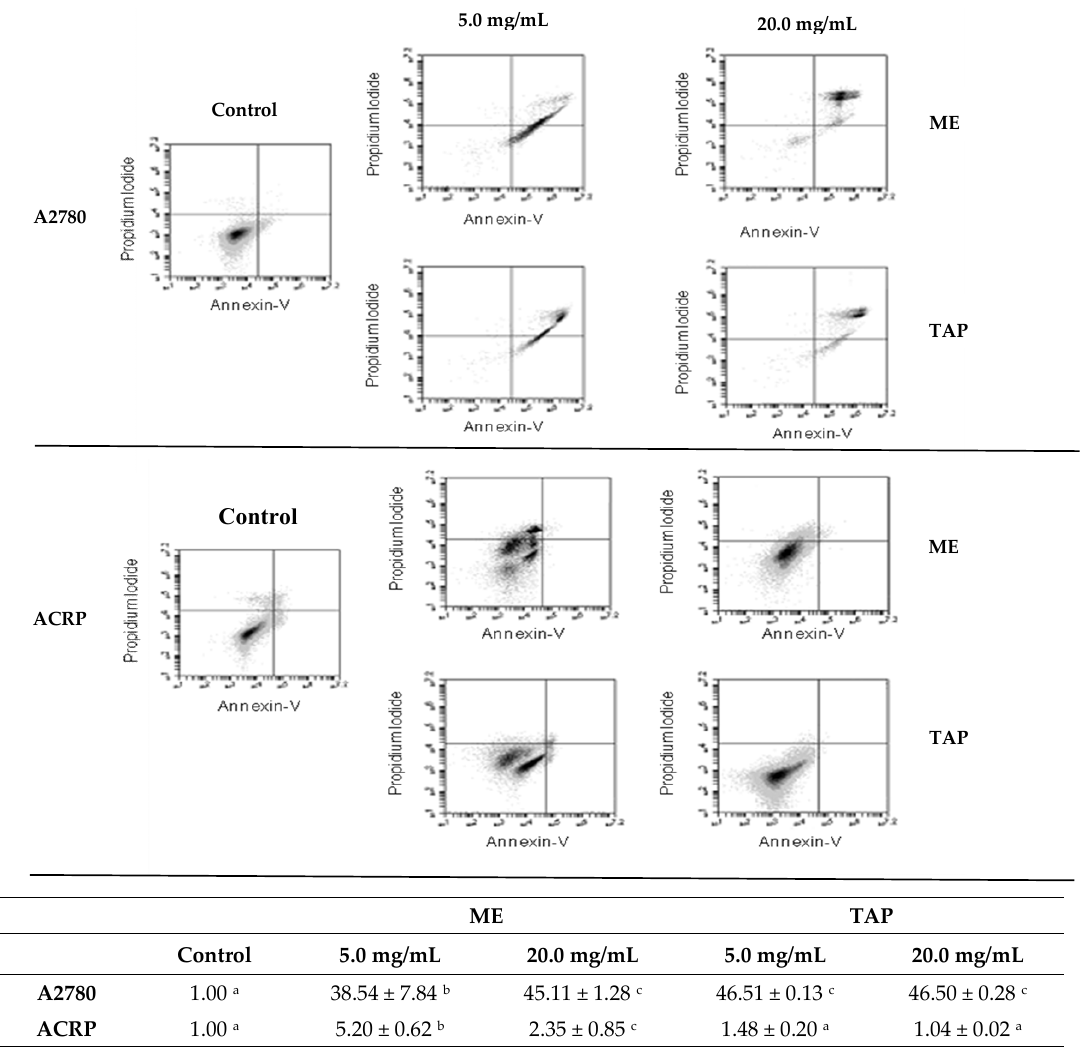
Figure 4. Effect of murici (ME) and tapereba (TAP) extracts on apoptotic rates in A2780 and ACRP cell lines. A2780 (top panel) and ACRP (bottom panel) cell lines were treated with ME or TAP for 24 h at 5 and 20 mg/mL. The table at the bottom part of this figure shows the apoptotic rates as described in the Material and Methods section. Different letters (a,b,c) in the same row indicate statistically significant differences ( p < 0.05).